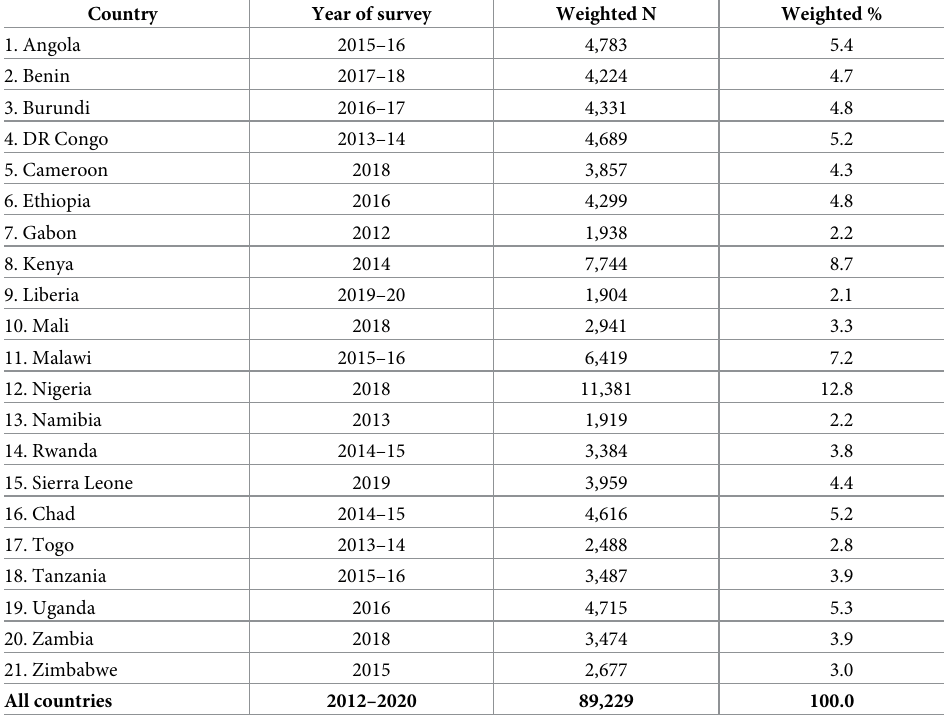
Table 1. Description of study